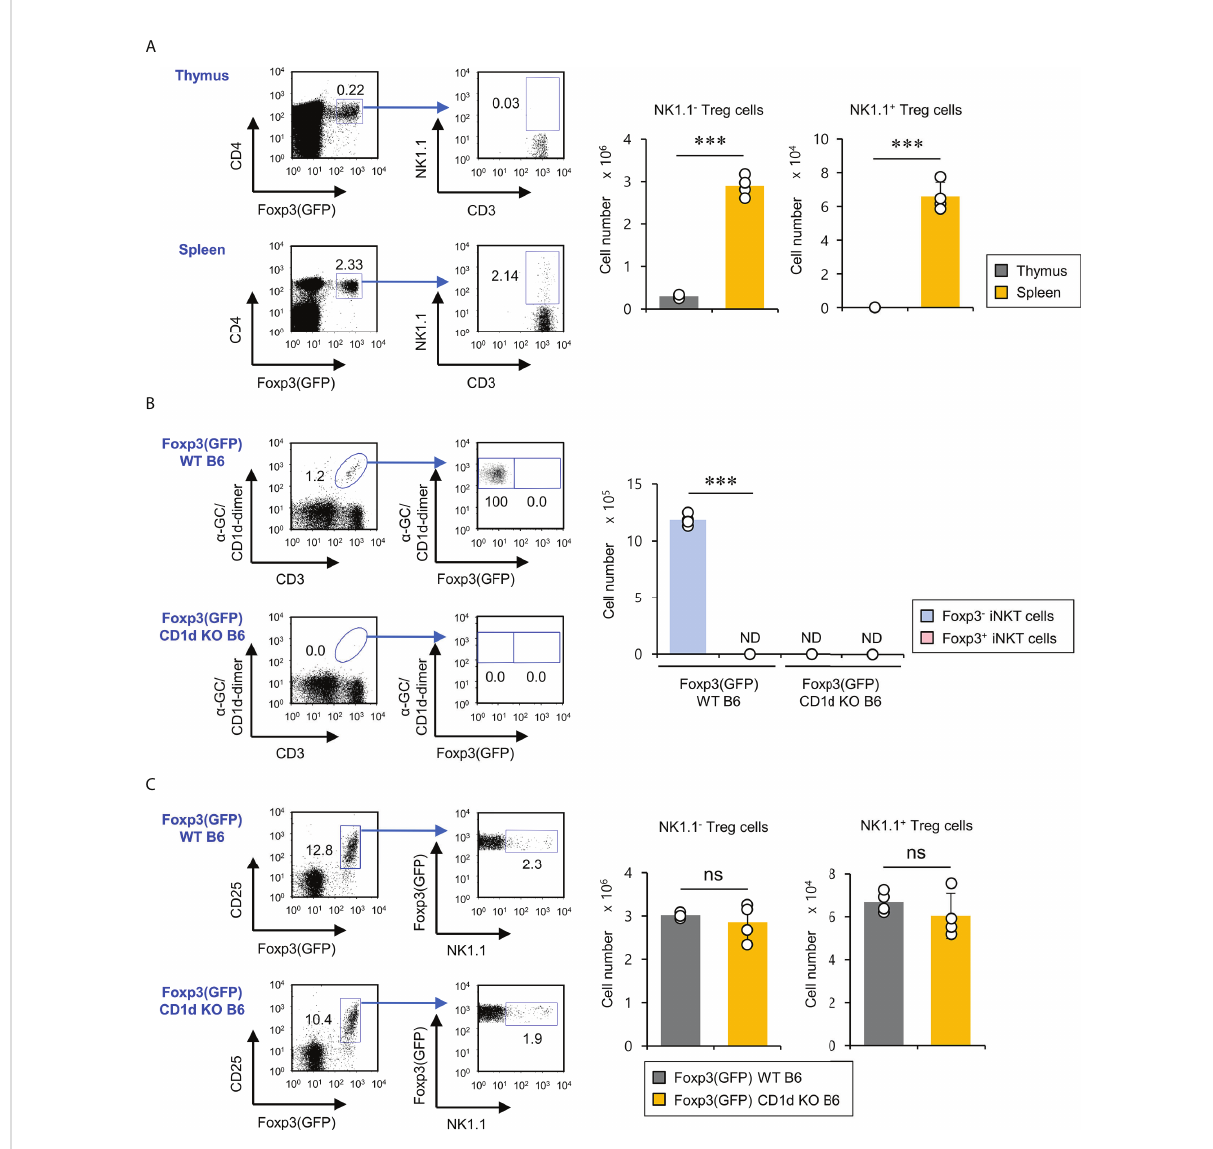
FIGURE 1 CD1d-independent NK1.1 + Treg cells exist in the spleen but not in the thymus. (A) Splenocytes and thymocytes were prepared from 8-week-old Foxp3(GFP) WT B6 mice. Left, the percentages of NK1.1 + subpopulations among splenic and thymic Treg cells (CD3 + CD4 + Foxp3(GFP) + ) were plotted. Right, the absolute cell number of NK1.1 - Treg and NK1.1 + Treg cells was assessed by fl ow cytometry. (B) Left, the percentages of Foxp3 (GFP) + subpopulations among splenic iNKT cells ( a -GC/CD1d dimer + CD3 + ) from 8-week-old Foxp3(GFP) WT or Foxp3(GFP) CD1d KO B6 mice were determined by fl ow cytometry. Right, the absolute cell numbers of splenic Foxp3 + iNKT or Foxp3 - iNKT cells from 8-week-old Foxp3(GFP) B6 or Foxp3(GFP) CD1d KO B6 were assessed by fl ow cytometry. (C) The percentages of NK1.1 + subpopulations among splenic Treg cells (CD3 + CD4 + Foxp3(GFP) + ) (left) and the absolute cell number of NK1.1 - Treg and NK1.1 + Treg cells (right) from 8-week-old Foxp3(GFP) WT or Foxp3(GFP) CD1d KO B6 mice were determined by fl ow cytometry. The mean values ± SD ( n = 4; per group in the experiment; Student ’ s t-test; *** p < 0.001) are shown. One representative experiment of three experiments is shown. ns, not signi fi cant; ND, not